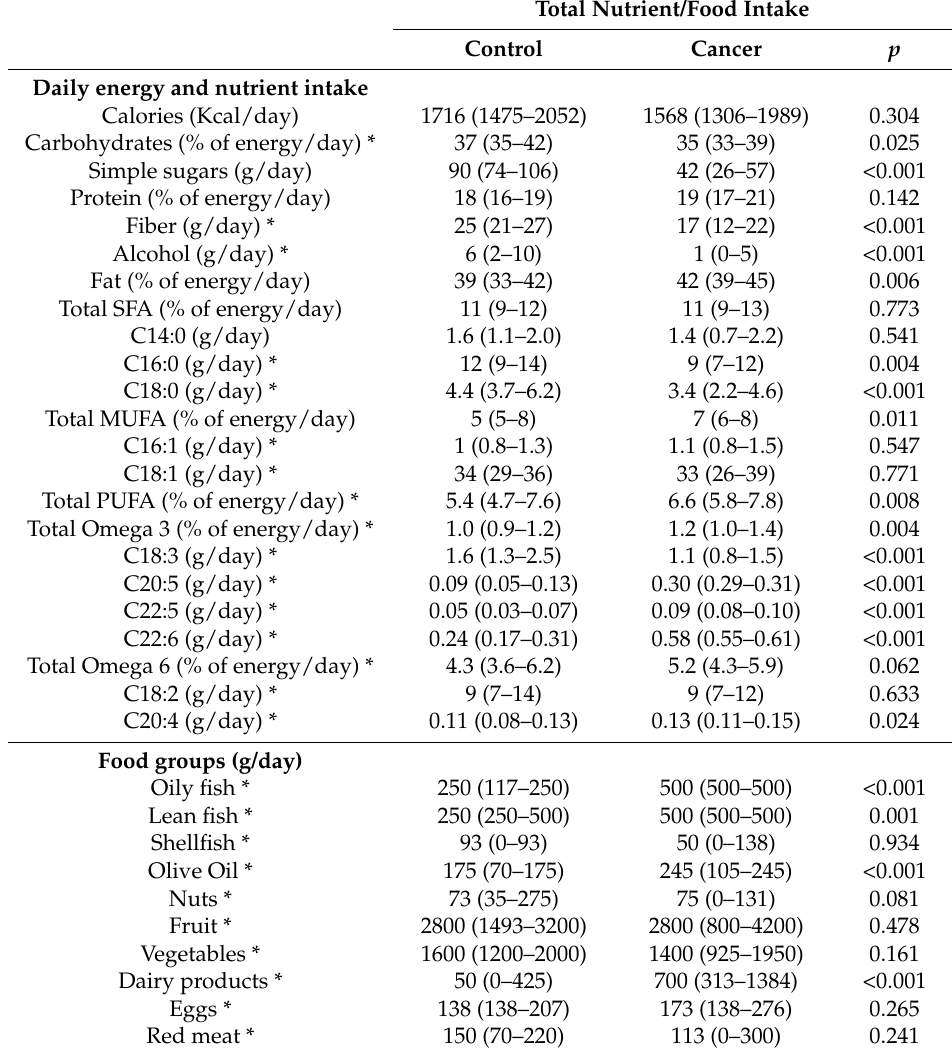
Table 2. Nutrients and food intake in cancer and control